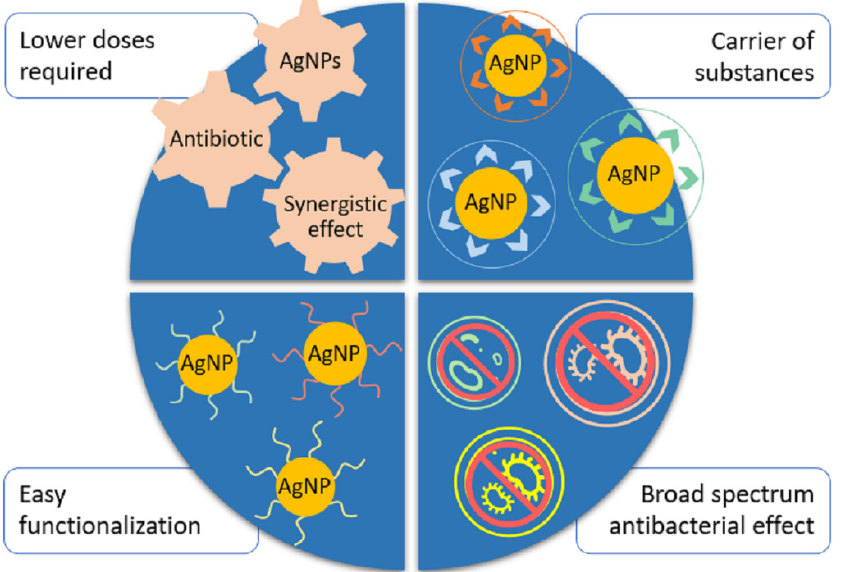
Figure 3. Advantages of using AgNPs in combination or as an alternative to antibiotics.